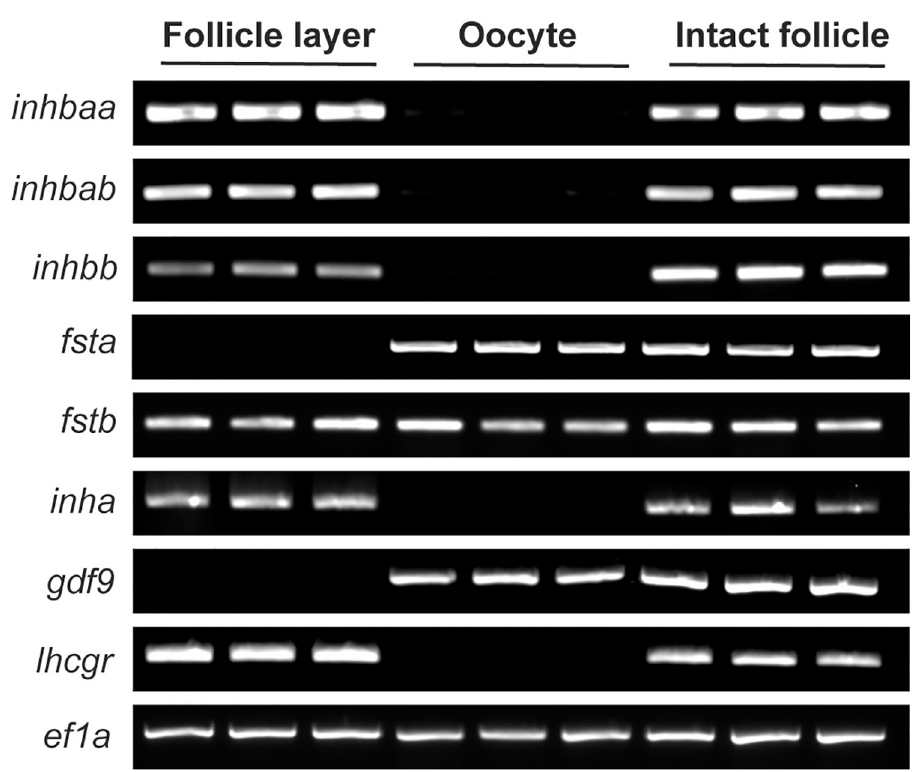
Fig 2. Intrafollicular distribution of activin-inhibin-follistatin system in full-grown (FG) follicles. The activin β subunits ( inhbaa , inhbab and inhbb ) and inhibin α ( inha ) were exclusively expressed in the follicle layer whereas follistatin a ( fsta ) was exclusively expressed in the oocyte. Follistatin b ( fstb ) was expressed in both follicle layer and oocyte. The housekeeping gene ( ef1a ) was expressed in both cell types, while gdf9 and lhcgr were exclusively expressed in oocyte and follicle layer, respectively, indicating clean separation of the two